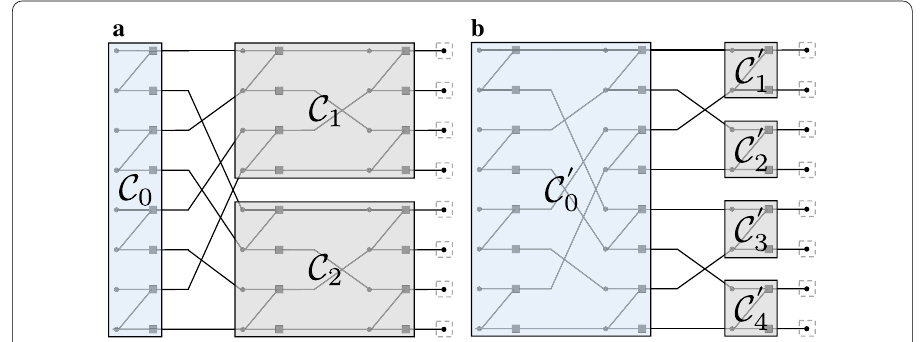
8 can be considered as two concatenated codes: a Two length‑4 outer codes C 1 Fig. 2 Polar code with N = and C 2 with the inner code C 0 . b Four length‑2 outer codes C ′ 1 , C ′ 2 , C ′ 3 , and C ′ 4 with the inner code C ′